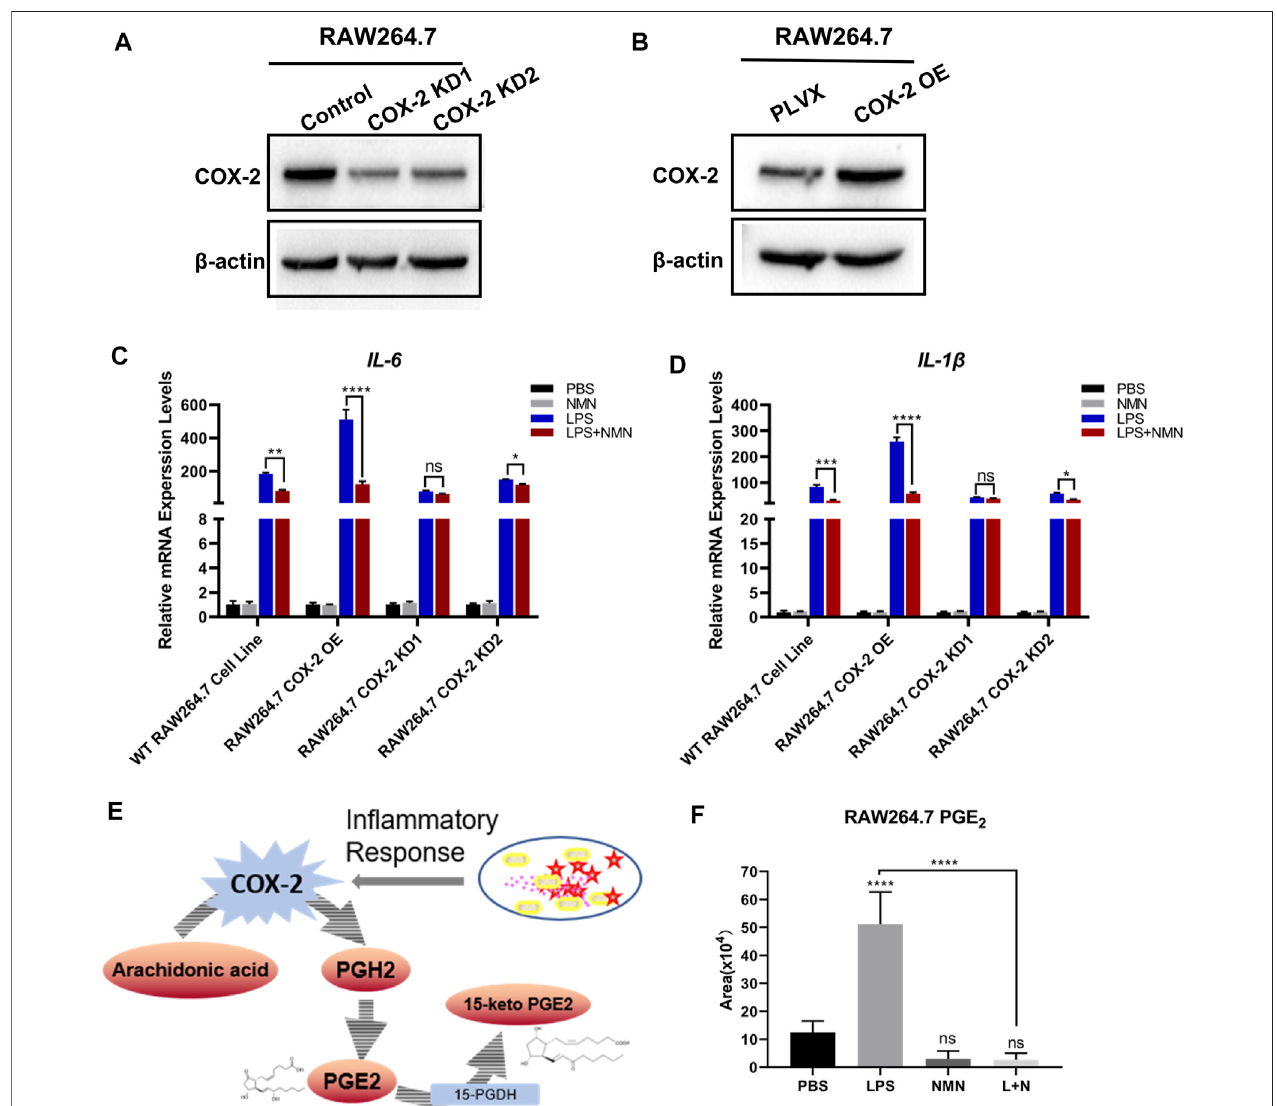
FIGURE 6 | NMN alleviated LPS-induced in fl ammation via decreasing COX-2 expression and inhibiting prostaglandin E 2 synthesis. (A) Western blotting of COX-2 revealed that the expression of COX-2 was reduced in RAW264.7-COX-2-KD cells. β -actin was used as a control. (B) Western blot analysis con fi rmed COX-2 overexpression in RAW264.7 cells. (C,D) The mRNA levels of IL-6 and IL-1 β were detectedby RT-qPCR( n (cid:2) 3) in WT RAW 264.7, RAW264.7-COX-2-OE, RAW264.7- COX-2-KD1andRAW264.7-COX-2-KD2celllinesunderNMNorLPSstimulated,respectively. (E)